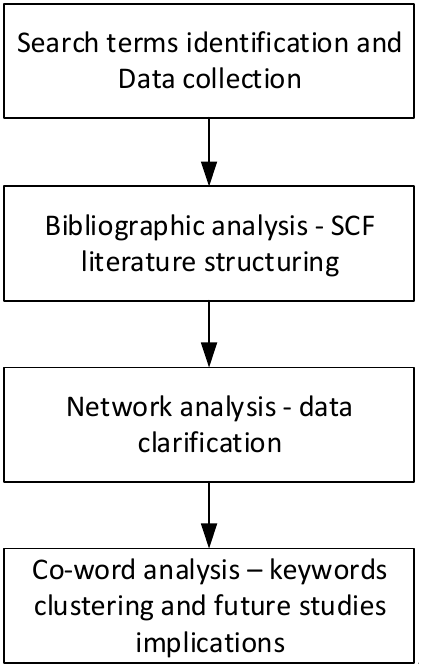
Figure 1. Proposed analysis steps.